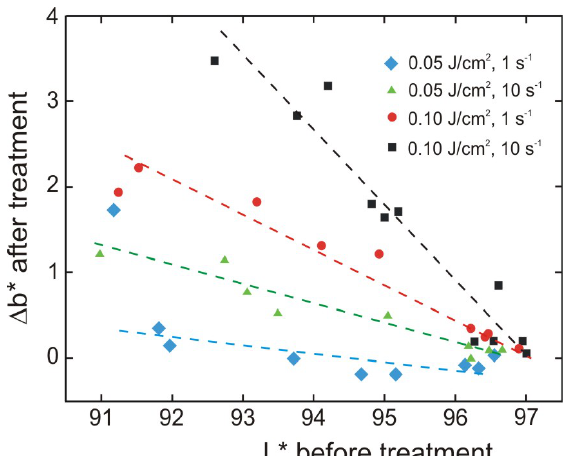
Figure 40. Yellowing of the substrate after laser cleaning at the conditions as indicated (Nd:YAG, 1064 nm), as a function of density of the deposited soiling. Higher Δ b * denotes more yellow component, lower L * denotes higher soiling